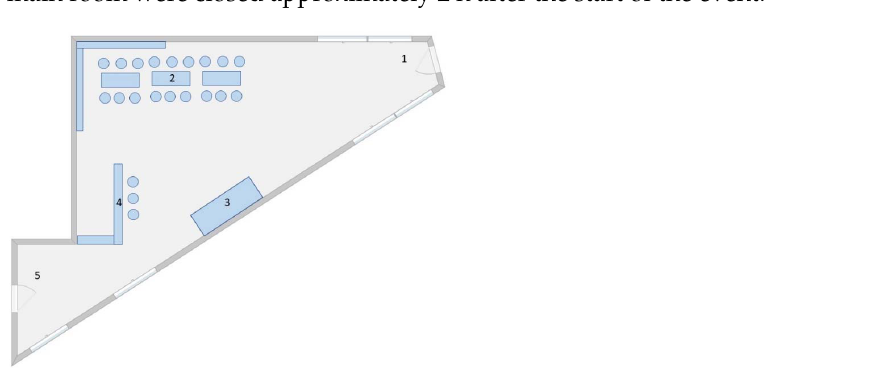
Figure 1. Floorplan of the venue in which the outbreak took place (only the main room is shown). Numerals represent the following: (1) entry area; (2) seating area; (3) sofa; (4) bar counter; (5) door to the garage. This figure is not drawn to scale.